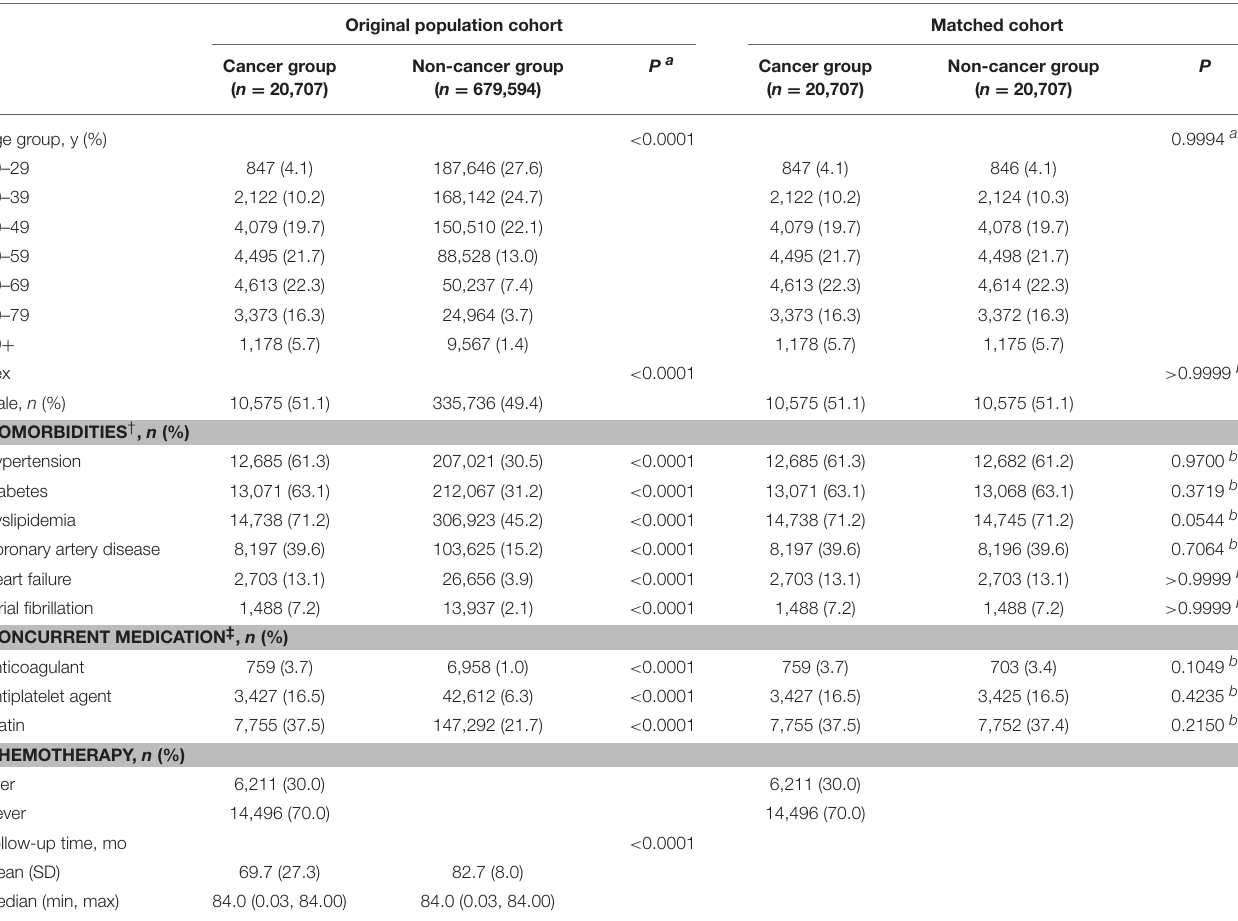
TABLE 1 | Comparison of baseline characteristics between subjects with and without